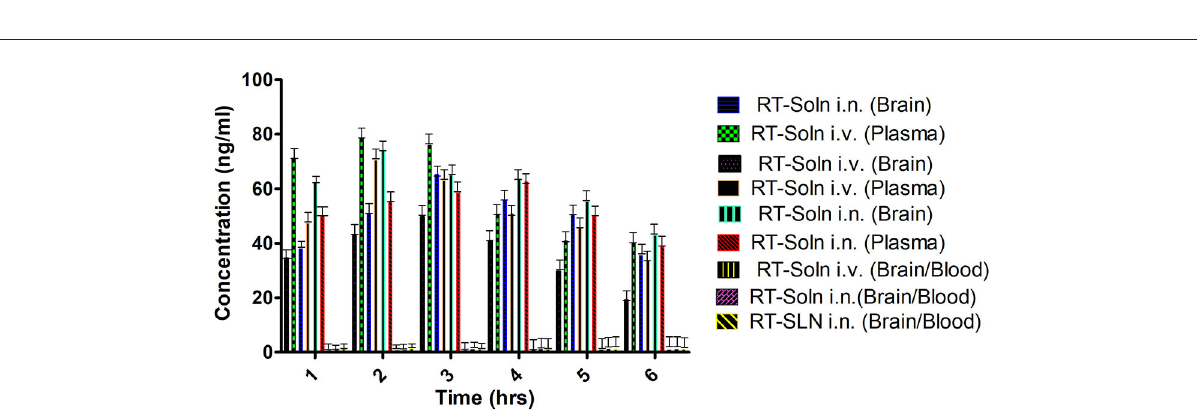
membrane, indicating the safety of the nasal administration